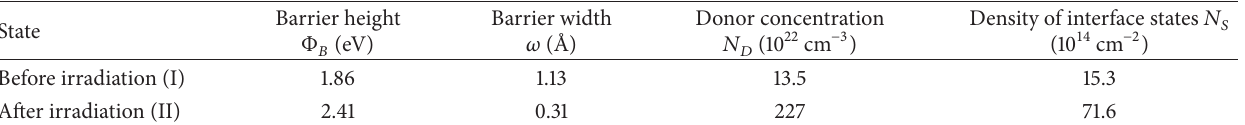
Table 2: The characteristic parameters of grain-boundary of ZnO-based ceramic films before and after laser-irradiation processing.